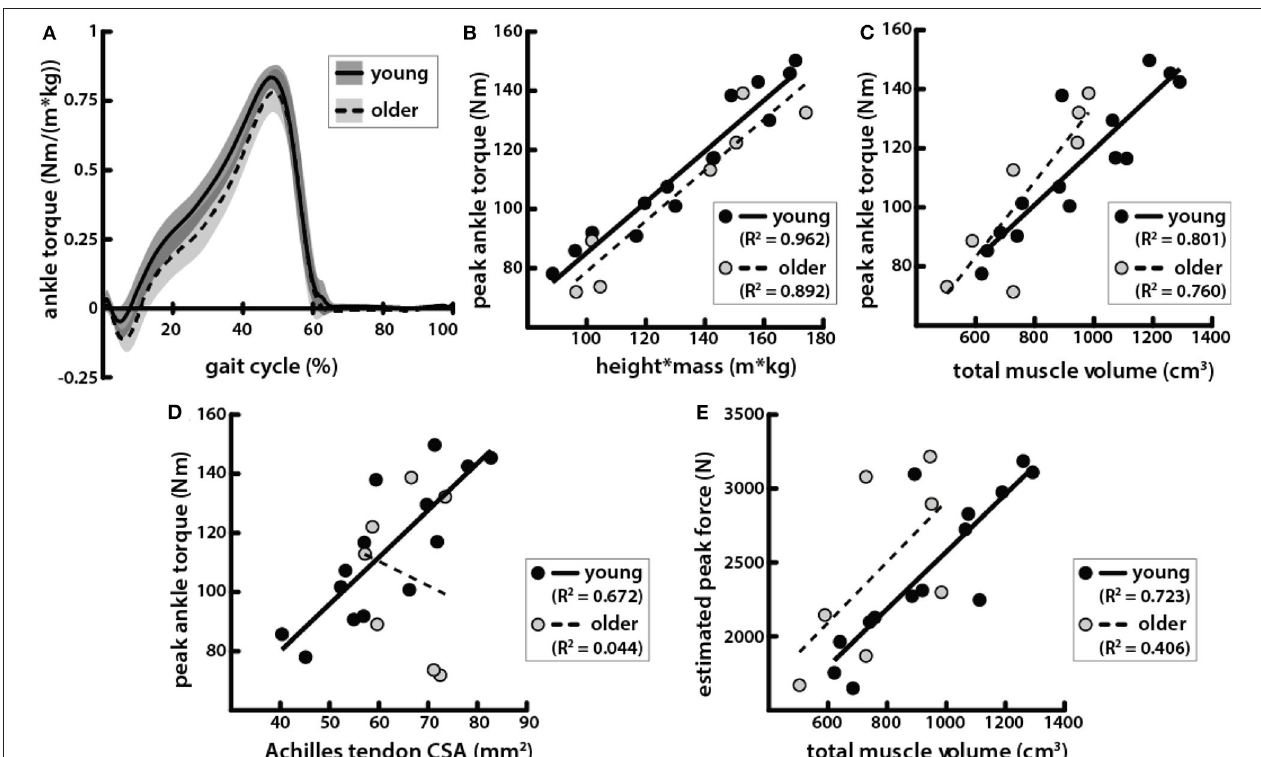
FIGURE 6 | Peak ankle plantarflexion torque during walking was correlated with body and muscle size in young and older adults but correlated with tendon size only in young adults. (A) Average ankle torque normalized by body size, calculated as the product of height and mass, in young (solid line, gray shading for standard deviation) and older (dotted line, light gray shading) adults walking at 1.25 m/s plotted over one gait cycle. (B) Peak plantarflexion torque during walking at 1.25 m/s vs. the product of height and mass in young (black circles, solid line: R 2 = 0.926, p = 3.77e − 8) and older (gray circles, dashed line: R 2 = 0.892, p = 1.35e − 3) adults. (C) Peak torque vs. total triceps surae muscle volume in young (black circles, solid line: R 2 = 0.801, p = 1.56e-5) and older (gray circles, dashed line: R 2 = 0.760, p = 0.010) adults. (D) Peak torque vs. Achilles tendon CSA in young (black circles, solid line: R 2 = 0.672, p = 3.31e − 4) and older (gray circles, dashed line: R 2 = 0.044, p = 0.651) adults. (E) Estimated peak forces, calculated by dividing peak torques by Achilles tendon moment arms, vs. total triceps surae muscle volume in young (black circles, solid line: R 2 = 0.723, p = 1.16e − 4) and older (gray circles, dashed line: R 2 = 0.406, p = 0.124)